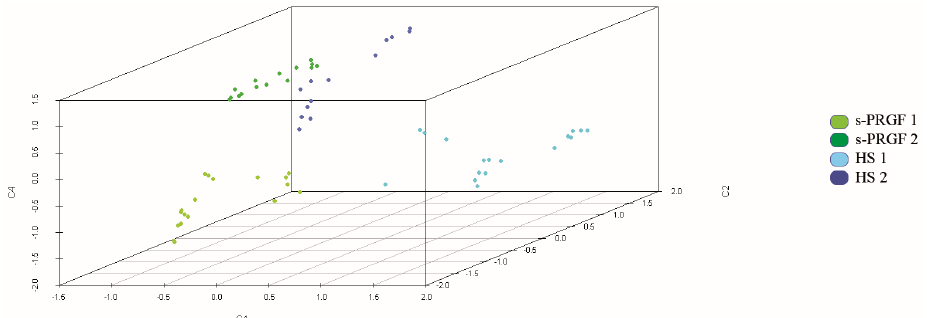
Figure 6. Figure 6. Representation of samples treated with human sera in three components obtained by PCA analysis. The analysis also included as variables some molecules measured in sera (glial cell-derived neurotrophic factor (GDNF), substance P (SP), epidermal growth factor (EGF)). Colors indicate treatments. Samples were well classified by treatment.